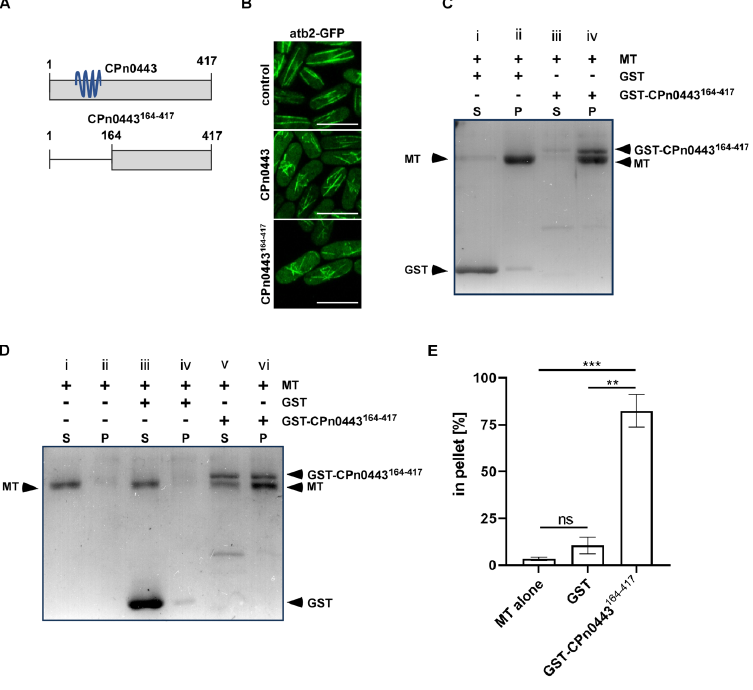
Figure 7. CPn0443 bound MTs. ( A ) Schematic illustration of the CPn0443 full-length protein and CPn0443 164-417 variant with deletion of the N-terminus. Transmembrane domains are shown in blue. ( B ) Photomicrographs of GFP- α -tubulin-expressing (green) S. pombe cells ( nmt81::GFP-atb2 + ) express- ing either CPn0443 or the variant CPn0443 164-417 . Expressions of both CPn0043 and CPn0443 164-417 gave rise to abnormally short MTs compared with the control cells. ( C ) A representative MT co- sedimentation assay showing a direct interaction between GST-CPn0443 164-417 and MTs. Bacterially expressed recombinant GST or GST-CPn0443 164-417 and porcine-derived Taxol-stabilized MTs were incubated at RT followed via high-speed centrifugation (100,000 × g ). Supernatant (S) and pellet (P) fractions were separated via a 15% SDS-PAGE followed by Coomassie staining. Matching control samples without MTs are found in Supplementary Figure S4B. ( D ) SDS gel analysis of the formation of higher-order MT structures was performed in the presence of GST or GST-CPn0443 164-417 and Taxol-stabilized MTs. After low-speed centrifugation (4000 × g ), equivalent amounts of pellet and supernatant were processed as in ( C ). ( E ) Quantification of the MTs found in pellet fractions shown in ( D ); ns, not significant; p < 0.0018 (**), p < 0.0008 (***). Results represent typical examples from three independent experiments. Error bars denote ± SEM. Two-tailed unpaired Student’s t -test was used to determine statistical